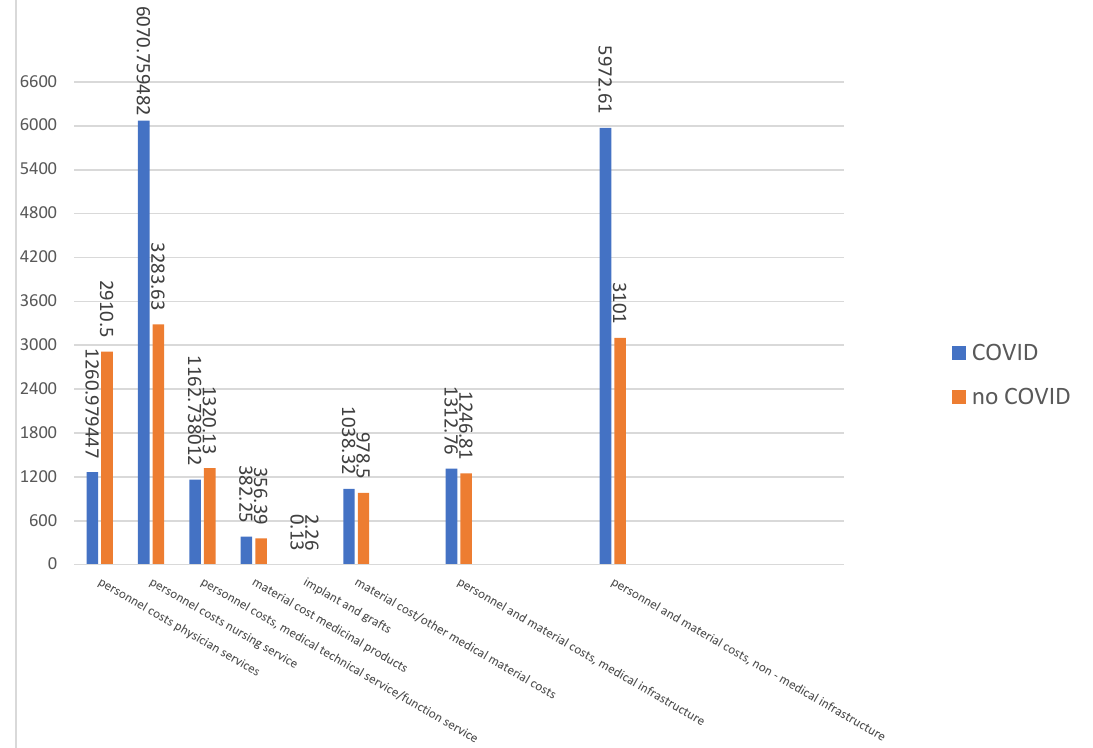
Figure 1. Distribution of secondary diagnoses from the examined COVID-19 patients. DC 1. Dis- eases and Disorders of the Nervous System. DC 4. Diseases and Disorders of the Respiratory Sys- tem. DC 5. Diseases and Disorders of the Circulatory System. DC 6. Diseases and Disorders of the Digestive System. DC 8. Diseases and Disorders of the Musculoskeletal System And Connective Tissue. DC 10. Diseases and Disorders of the Endocrine, Nutritional And Metabolic System. DC 11. Diseases and Disorders of the Kidney And Urinary Tract. DC 16. Diseases and Disorders of the Blood and Blood Forming Organs and Immunological Disorders. DC 19. Mental Diseases and Dis- orders. DC 23. Factors Influencing Health Status and Other Contacts with Health Services. A total of 73 diagnoses were made in the examined COVID-19 patients, 22% of them from DC 1, followed by DC 5, 8, 10 with 13% each. The treated COVID-19 patients had an average of 10.5 diagnoses. Frequent comorbidities were heart failure, diabetes mellitus, other respiratory diseases, dizziness, and impairment of the musculoskeletal system.